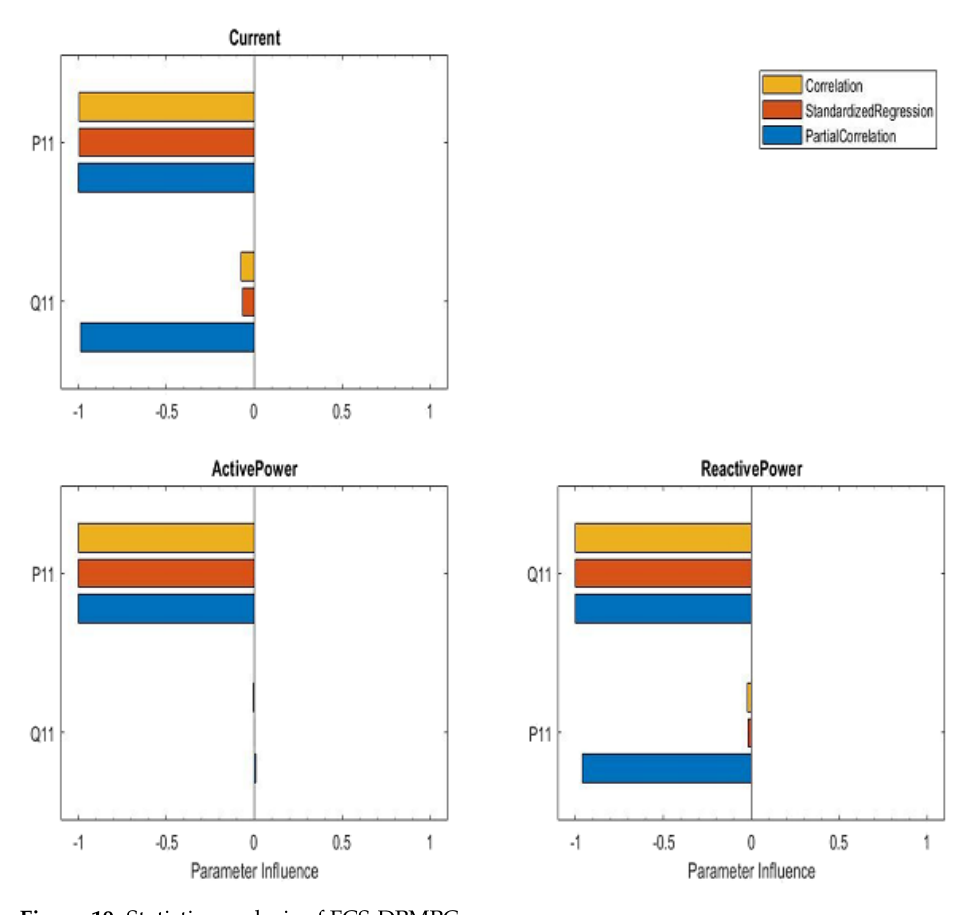
Figure 19. Statistics analysis of FCS-DPMPC.